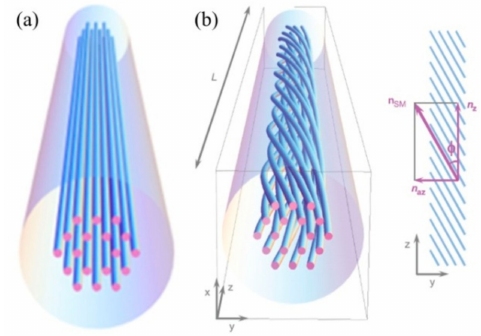
Figure 8. Schematics of ( a ) a solid-core PCF and ( b ) HLPFG in PCF. The blue tubes are the air-hole channels in the cladding area